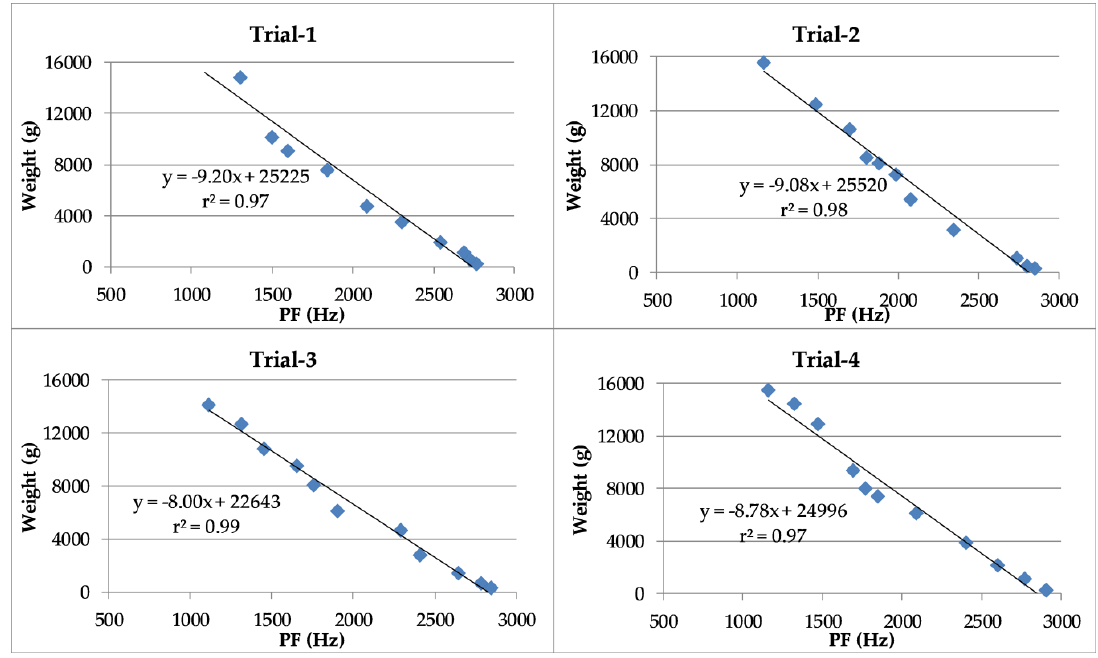
Figure 6. Linear regressions and coefficients of determination between turkey weight and peak frequency (PF) of the vocalizations.